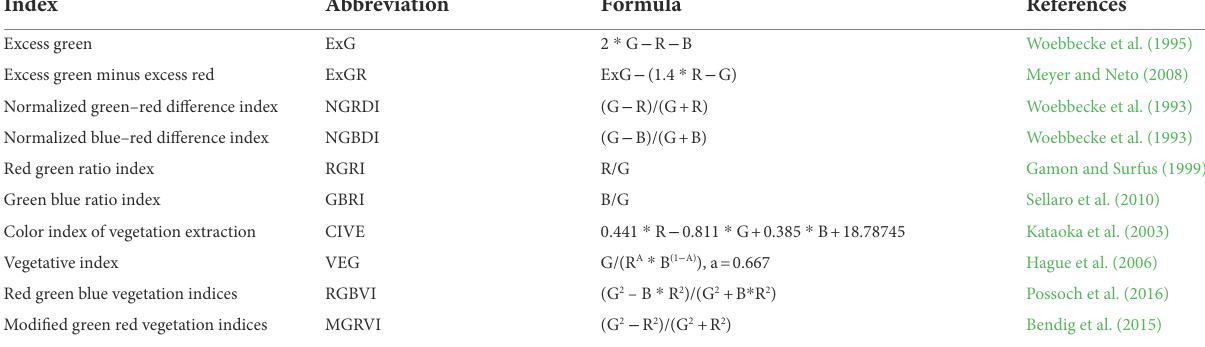
TABLE 2 The information of RGB VIs.